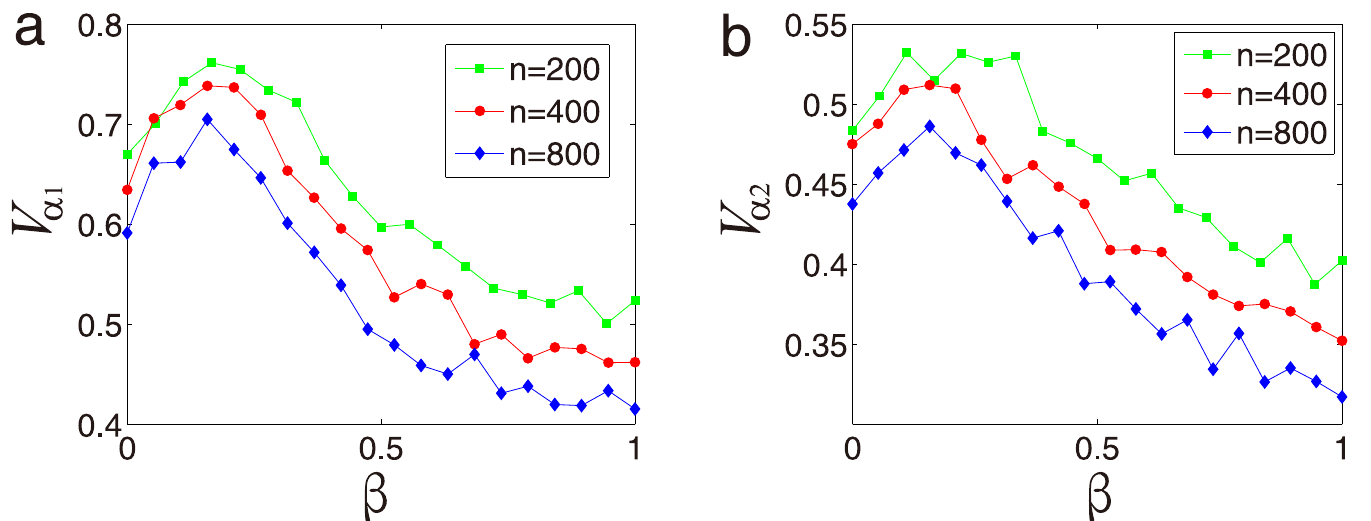
Fig 5. System size effect for predator-prey relationship. (a) Synchronization V α 1 as a function of the coupling strength β for the subsystem of predators. (b) Synchronization V α 2 as a function of the coupling strength β for the subsystem of preys. All the data points are in S4 File.